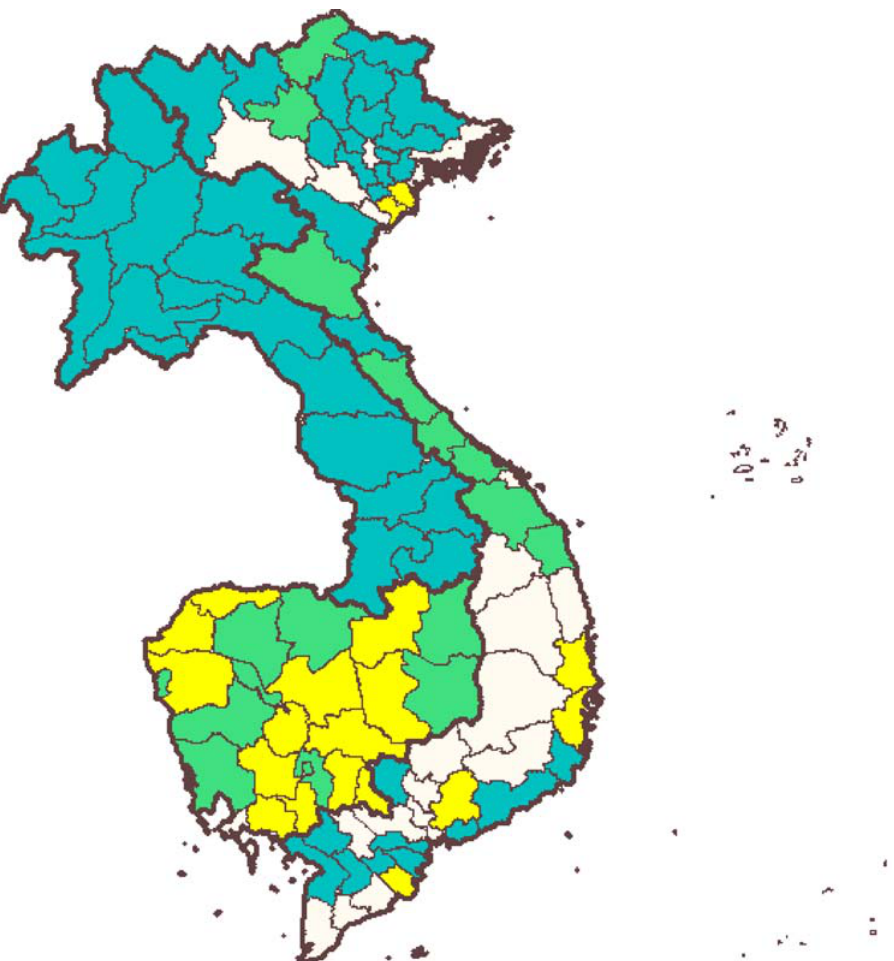
Figure 1. Scaling Up of Preventive Chemotherapy for Schoolchildren in Mekong Countries between 2002 and 2006. Provinces in which all primary schools were covered by the deworming intervention in 2002 are indicated in yellow, the additional provinces covered in 2004 in green, and the additional provinces covered in 2006 in blue.